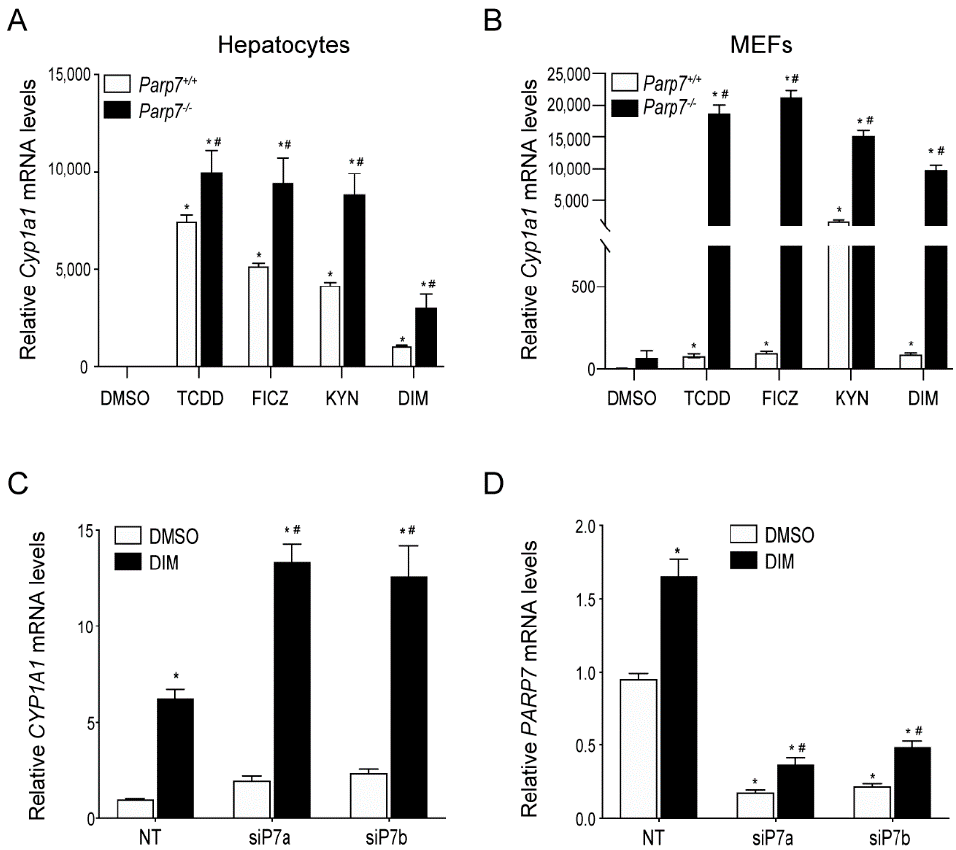
Figure 1. PARP7 represses CYP1A1 expression in MEFs, hepatocytes and Caco-2 cells. AHR ligand induced Cyp1a1 levels are higher in ( A ) hepatocytes and ( B ) MEFs isolated from Parp7 − / − compared to Parp7 +/+ mice. Hepatocytes and MEFs were isolated from livers of Parp7 − / − and Parp7 +/+ mice and treated with DMSO, 10 nM TCDD, 10 nM FICZ, 200 µ M KYN or 10 µ M DIM for 6 h. The Cyp1a1 mRNA levels were determined with RT-qPCR. * p < 0.05 two-way ANOVA compared with genotyped-matched control treated hepatocytes or MEFs. # p < 0.05 two-way ANOVA compared with ligand matched Parp7 +/+ hepatocytes or MEFs. ( C , D ) RNAi-mediated knockdown of PARP7 increased DIM-induced CYP1A1 levels. Caco2 cells were transfected with two different siRNAs targeting PARP7 and treated with DMSO and 10 µ M DIM for 6 h. Relative CYP1A1 mRNA and PARP7 mRNA levels were determined with RT-qPCR. * p < 0.05 two-way ANOVA compared with control treated non-targeted (NT) Caco-2 cells. # p < 0.05 two-way ANOVA compared with DIM-treated NT Caco-2 cells.